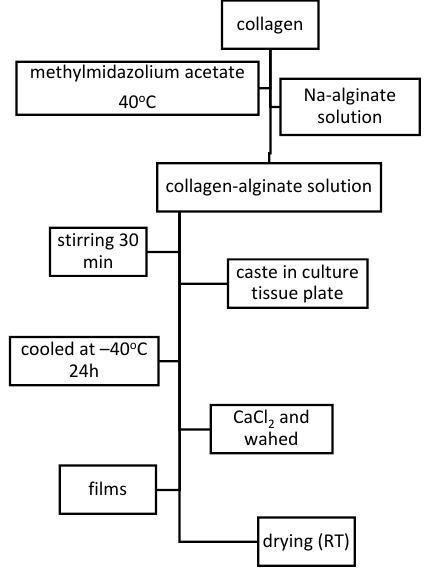
Figure 4. Synthesis of collagen–alginate